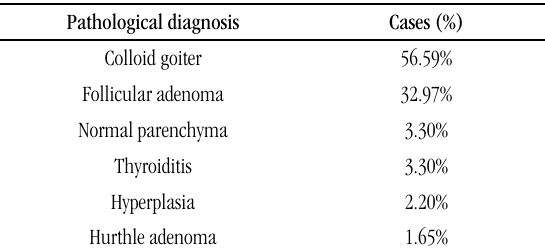
tABLE 2 – Benign findings from the pathological